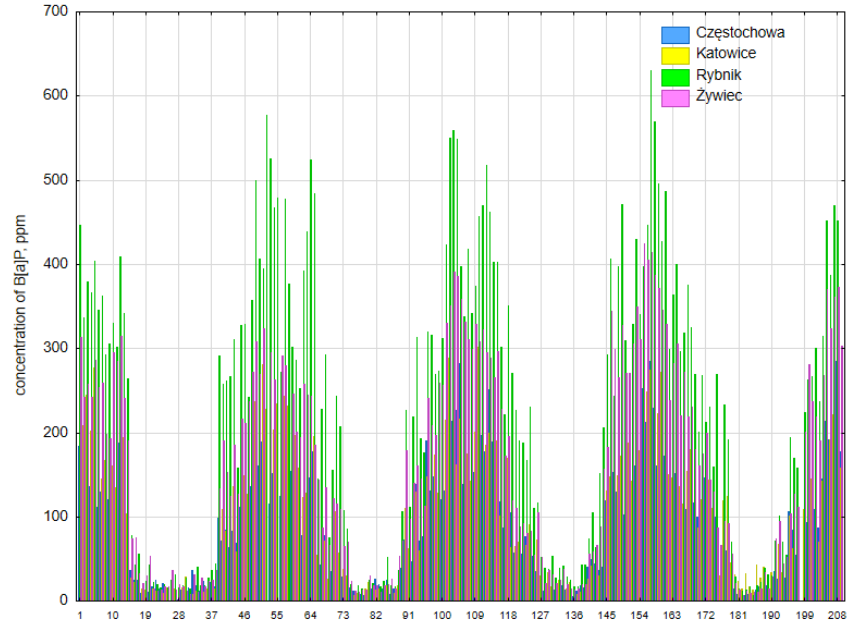
Figure 6. Distribution of 1 h PM10 concentrations and recorded meteorological parameters from 1– 6 March 2018 in Rybnik.